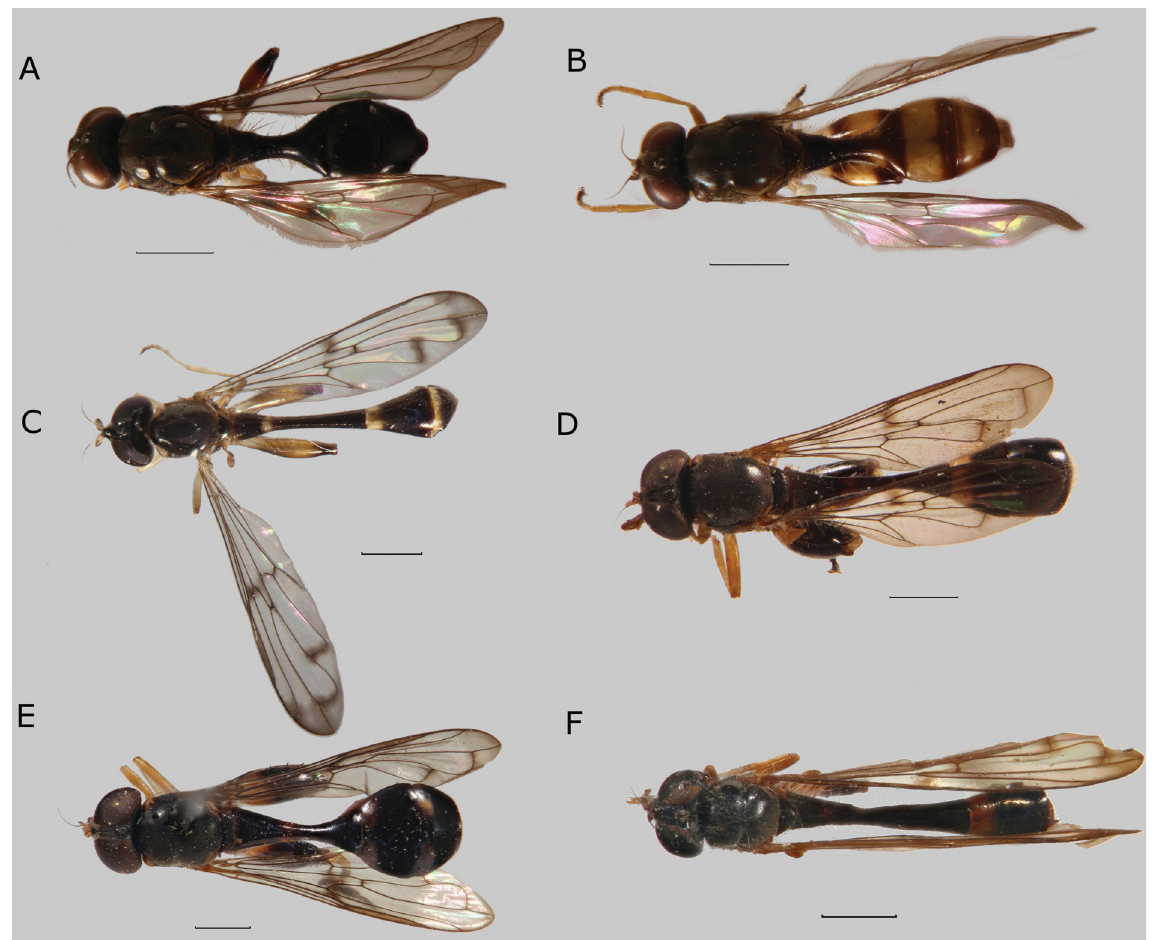
Fig. 70. Habitus, dorsal view. A. Sphegina (Asiosphegina) nubicola sp. nov., paratype, ♀ ,